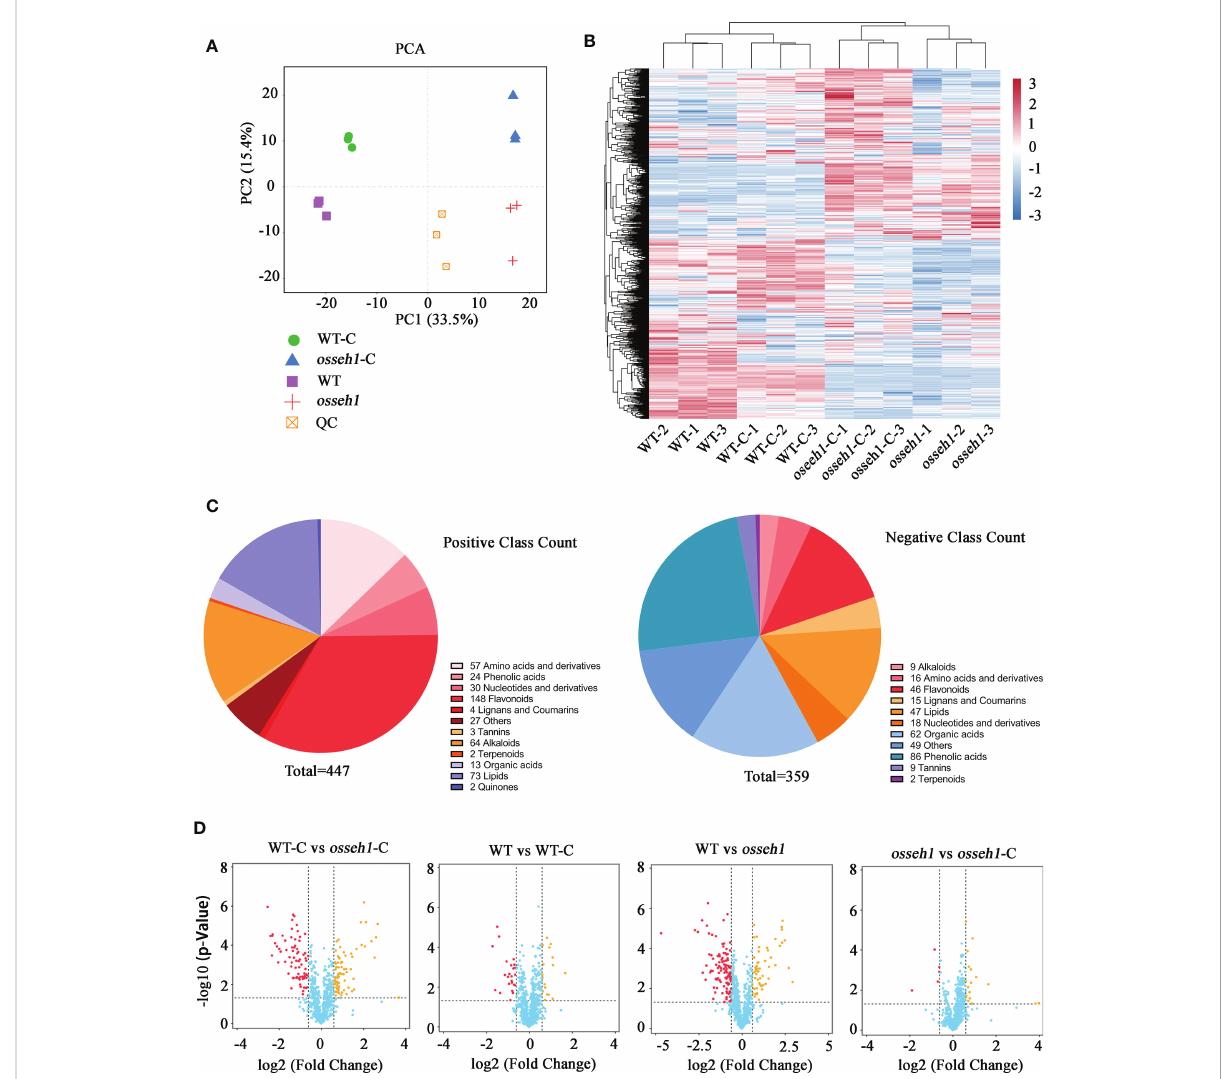
FIGURE 2 Overview of the metabolite accumulation under normal and cold condition. (A) Principal component analysis (PCA) of the metabolic pro fi les. PC1 and PC2 indicate principal component 1 and principal component 2, respectively. The quality control sample (QC) was prepared by mixing aliquots of all of the samples. (B) Heat map visualization of metabolites. The content of each metabolite was normalized to complete linkage hierarchical clustering. (C) Classi fi cation map of metabolites under positive and negative iron mode. (D) Volcano plots of the metabolites from the comparison of WT-C vs. osseh1 -C, WT vs. WT-C, WT vs. osseh1 and osseh1 vs. osseh1 -C, respectively. WT, WT under normal condition. WT-C, WT under cold treatment. osseh1 , osseh1 lines under normal condition. osseh1 -C, osseh1 lines under cold